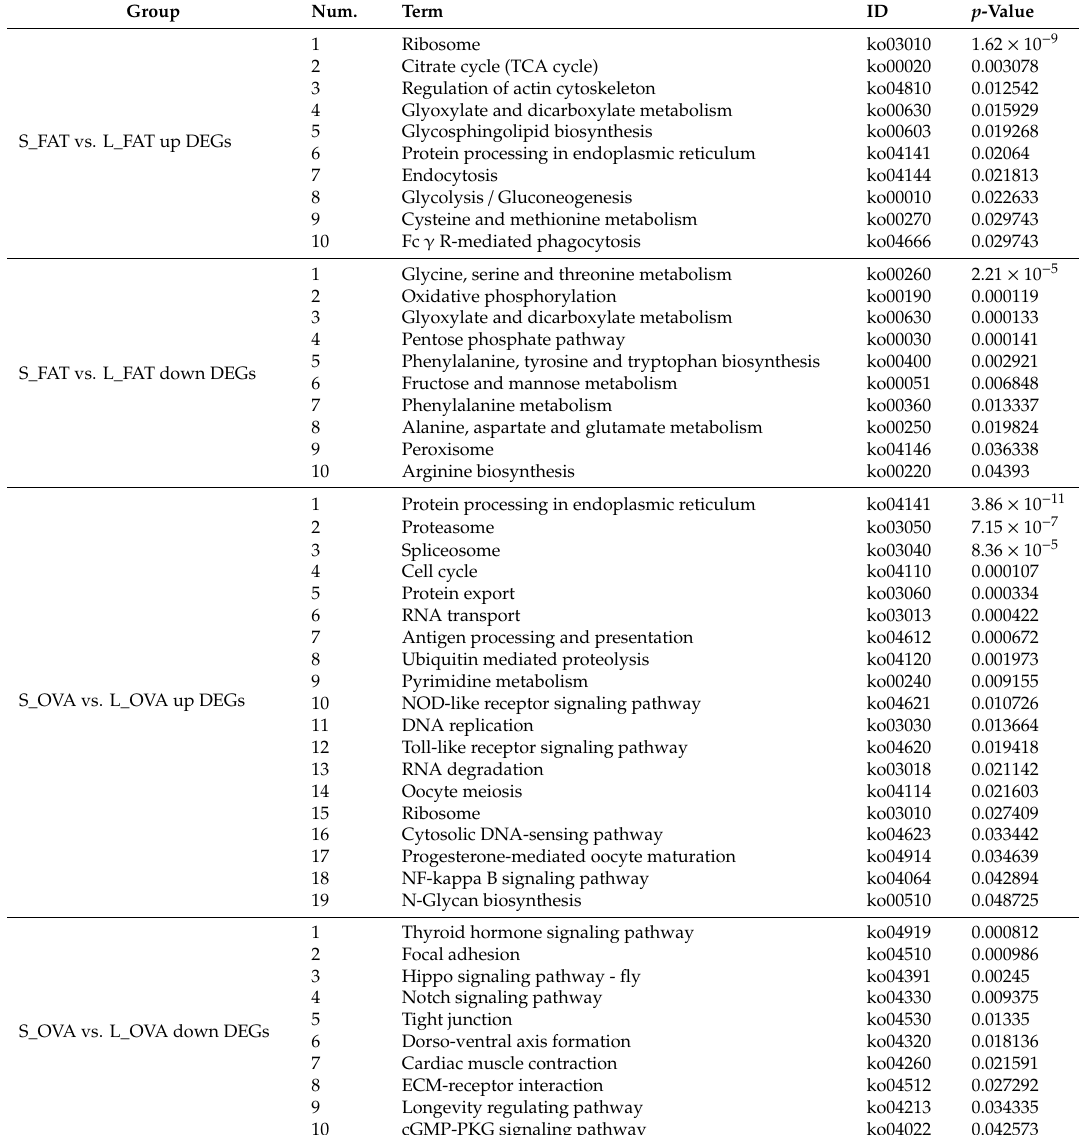
Table 2. DEGs of di ff erent groups enriched KEGG